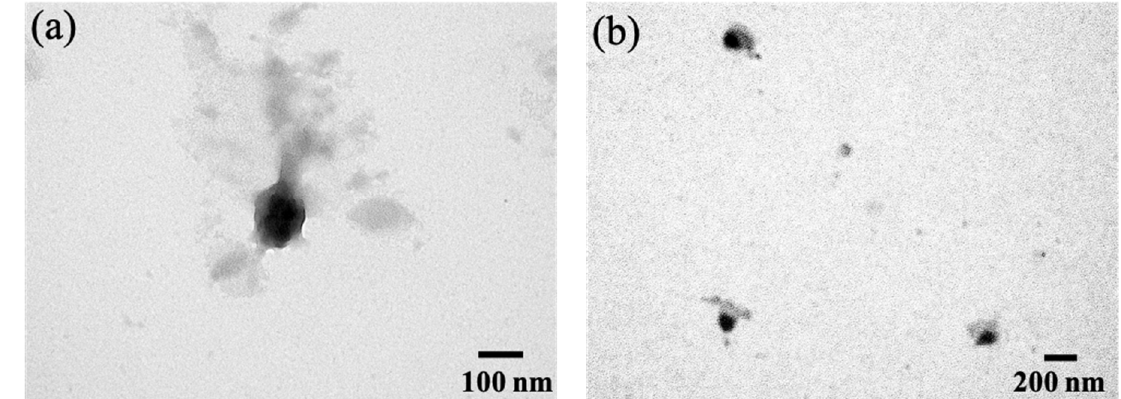
Figure 5. Transmission electron microscopic (TEM) images of MPT0B291-human serum albumin (HSA) nanoparticles (NPs). Scale bars represent 100 ( a ) and 200 nm ( b ).